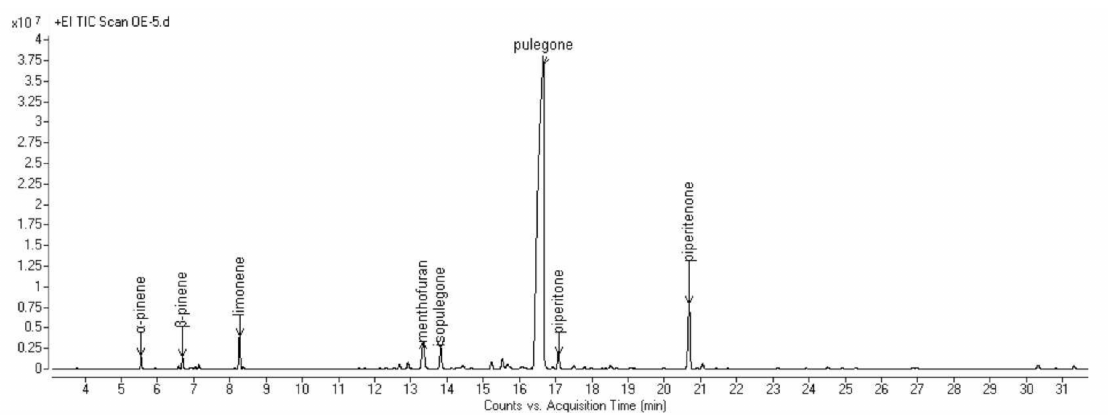
Figure 5. GC chromatogram of the EO hydrodistilled from the aerial parts of M. pulegium L. Forty compounds were identified in L. o ffi cinalis EO, representing 98.5% of the total. Almost 90% of its composition was constituted by oxygenated monoterpenes, of which linalool and linalyl acetate were the most abundant, as they accounted for up to 35.8% and 21.0%,